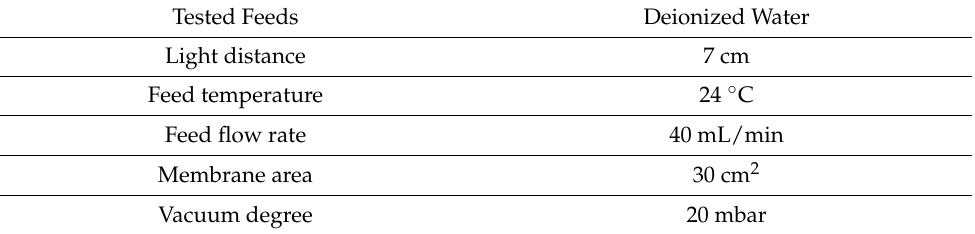
Table 2. DSMD tests